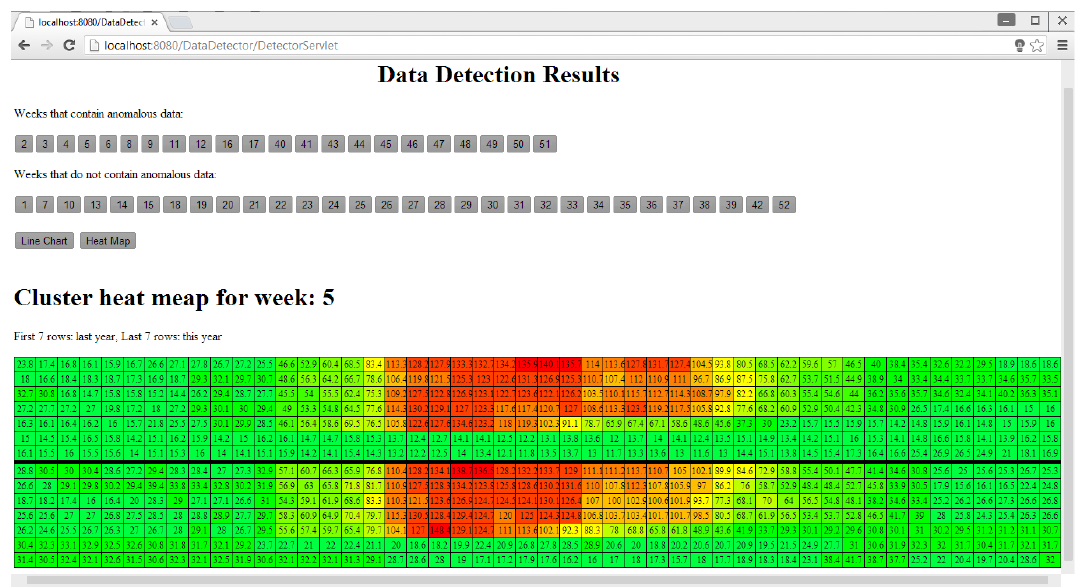
Figure 15. The heat map of the 5th week’s electricity consumption data of a school